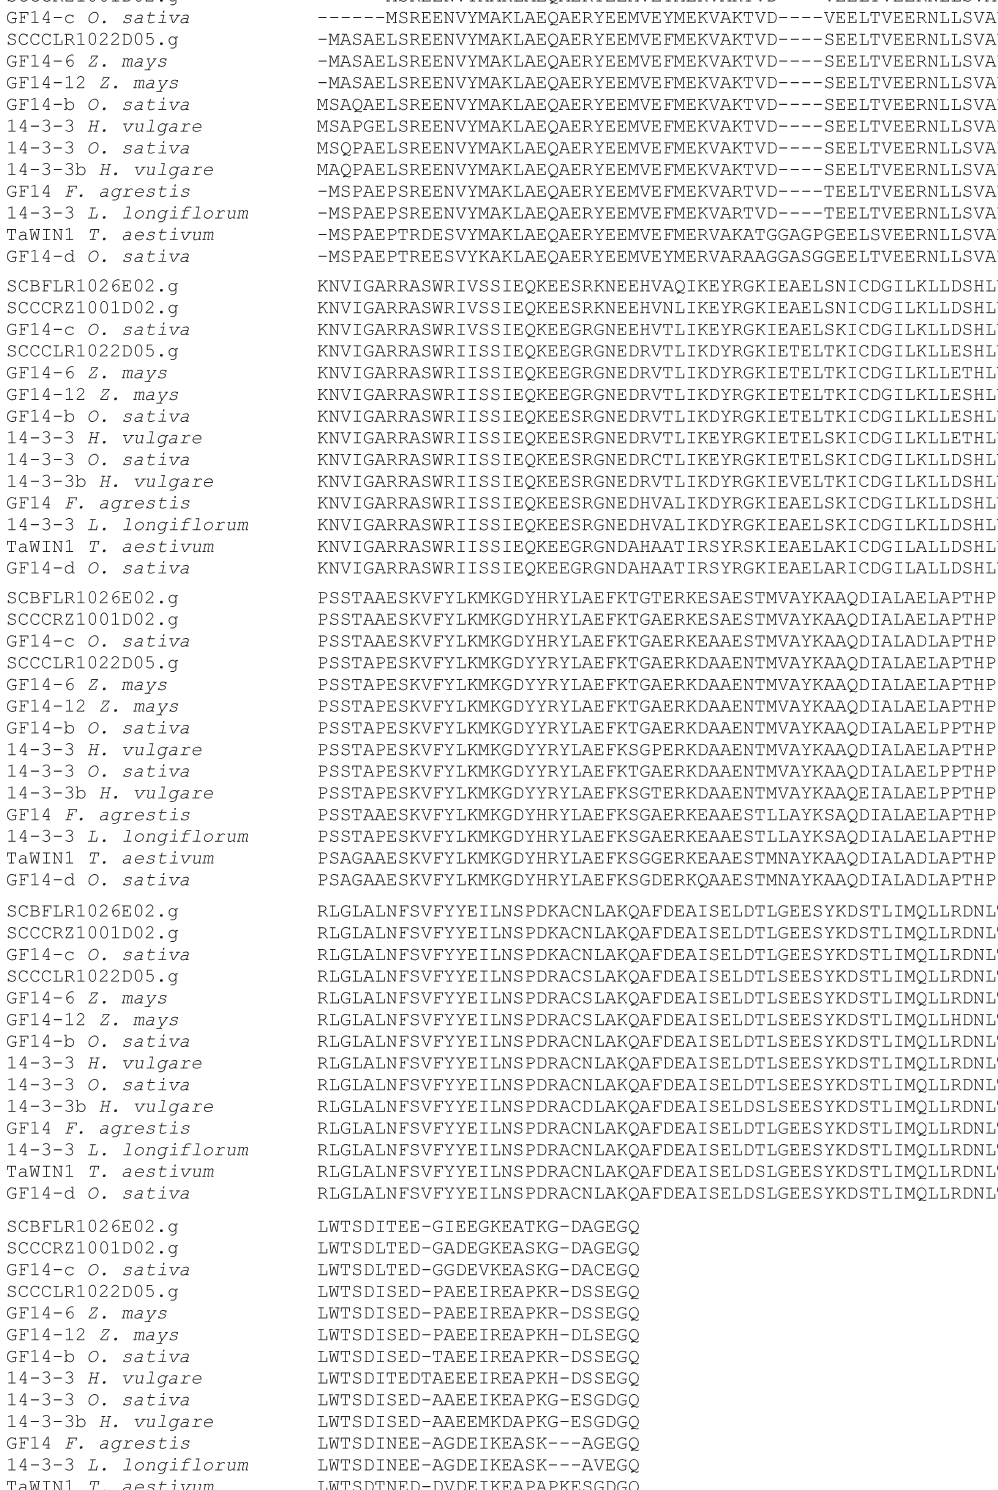
Figure 2 - Alignment of the deduced amino acid sequences of sugarcane expressed sequence tag (EST) clusters SCCCLR1022D05.g, SCCCRZ1001D02.g and SCBFLR1026E02.g with 14-3-3 proteins from Oryza sativa 14-3-3 (gi|7271253), GF14-c (gi|7435022), GF14-b (gi|7435021), and GF14-d (gi|7435023), Zea mays GF14-6 (gi|1345587) and GF14-12 (gi|1345588), Hordeum vulgare 14-3-3 (gi|7435015) and 14-3-3b (gi|2492487), Fritillaria agrestis GF14 (gi|2921512); Lilium longiflorum 14-3-3 (gi|12229593), Triticum aestivum TaWIN1